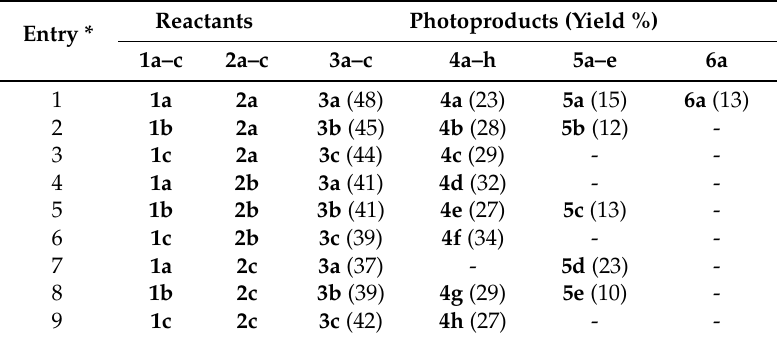
Table 1. Photoproducts from irradiation of 1,4-DHPs 1a – c with maleimides 2a – c.